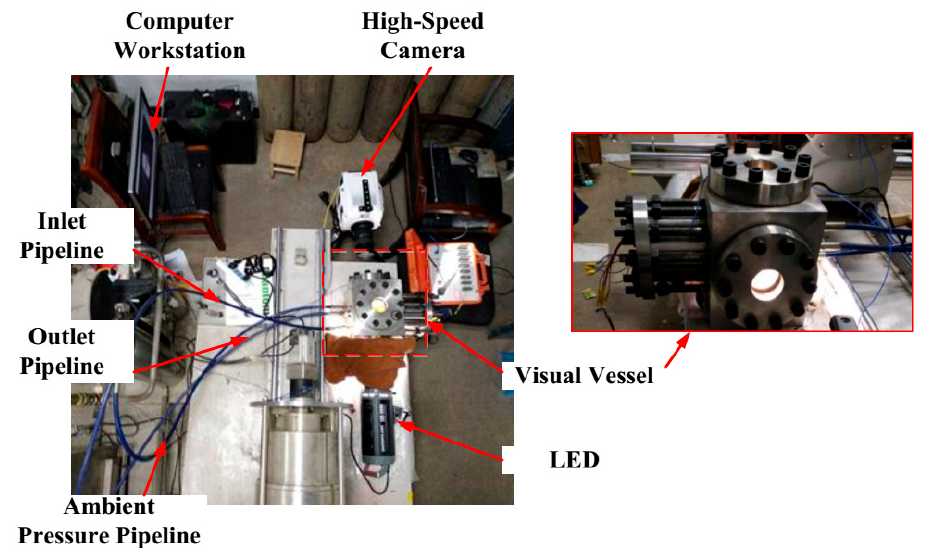
Figure 17. The schematic program of the visualized vessel and assisted testing facilities.